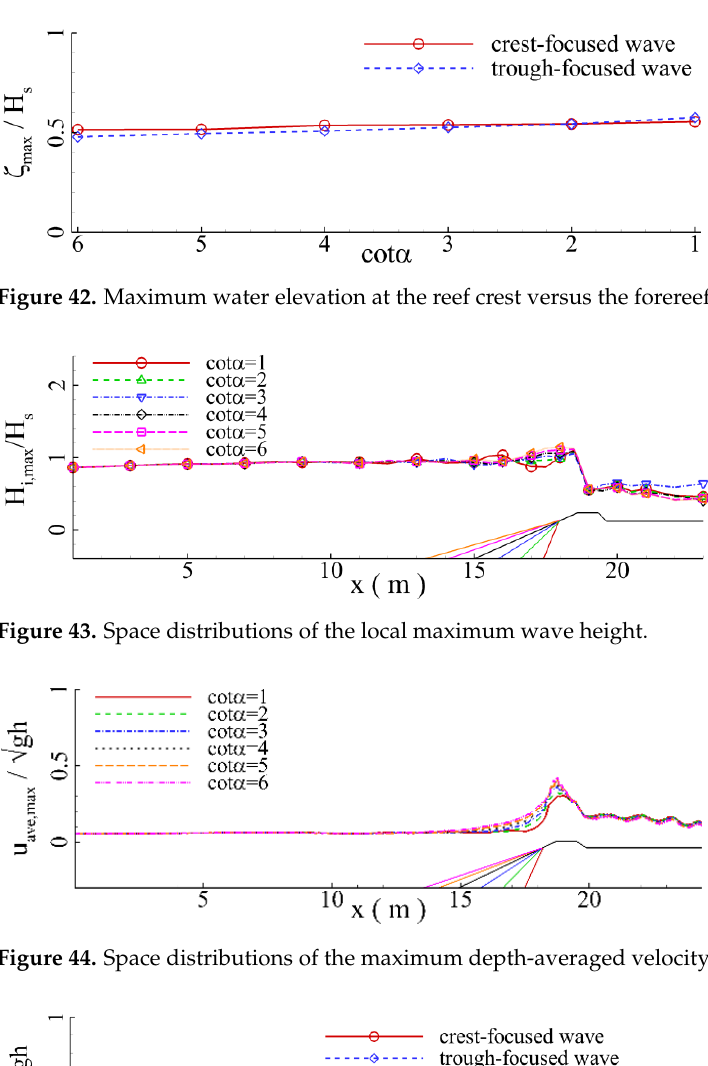
Figure 41. Space distributions of the maximum water surface elevation.